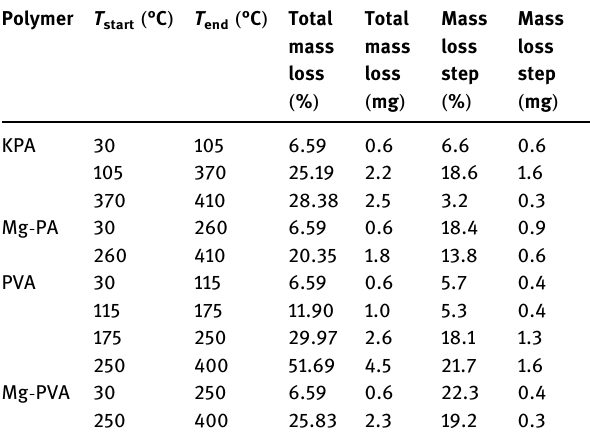
Table 1: Mass loss of KPA, Mg - PA, PVA, and Mg - PVA at various